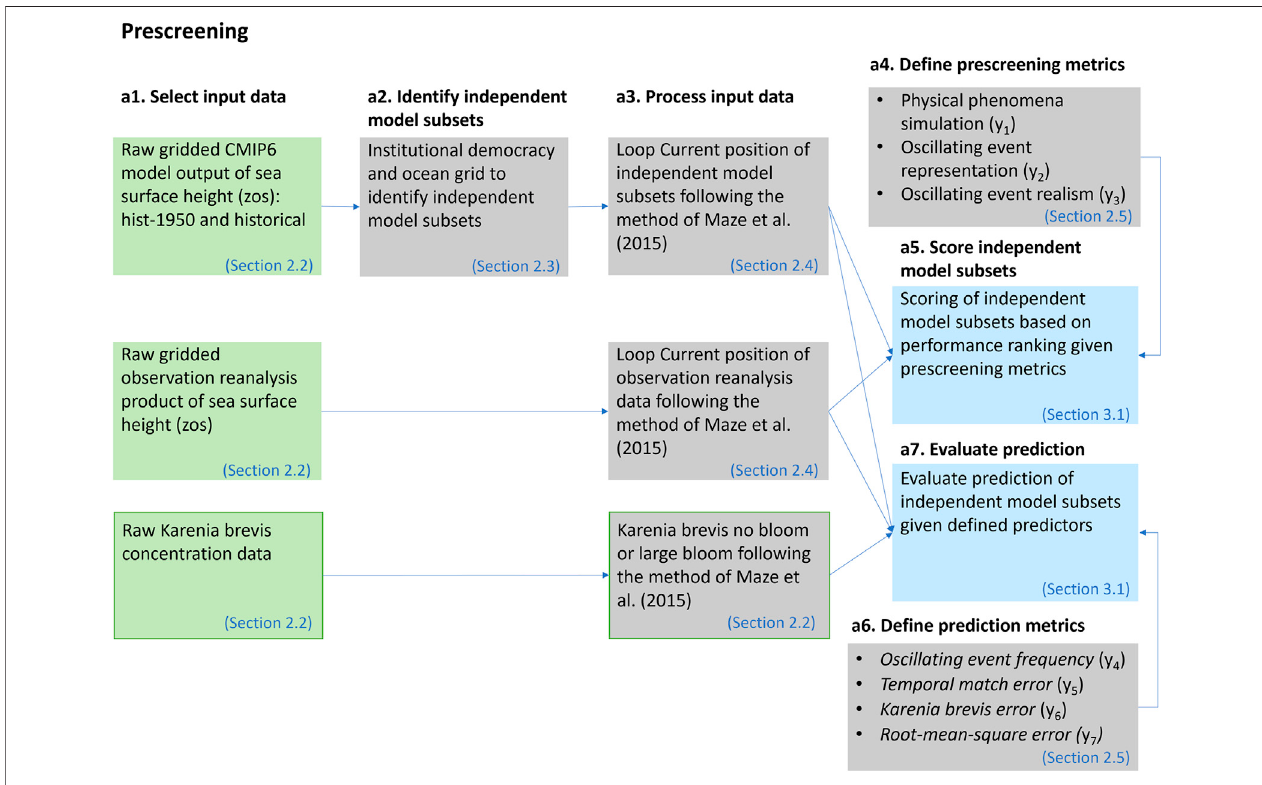
FIGURE 3 | The prescreening